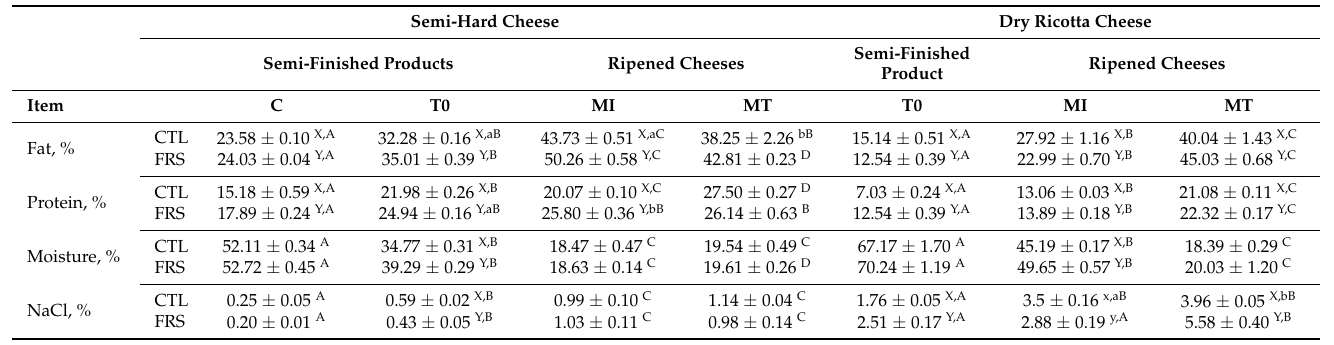
Table 2. Effects of feeding system and ripening time on chemical composition of dry ricotta cheeses and semi-hard